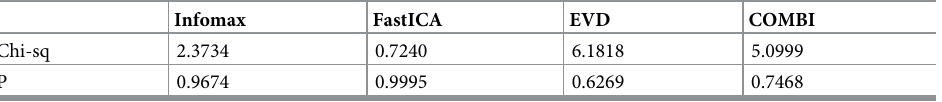
Table 6. Differences in SCC values between the most reliable ICASSO results and the other nine results (sensory